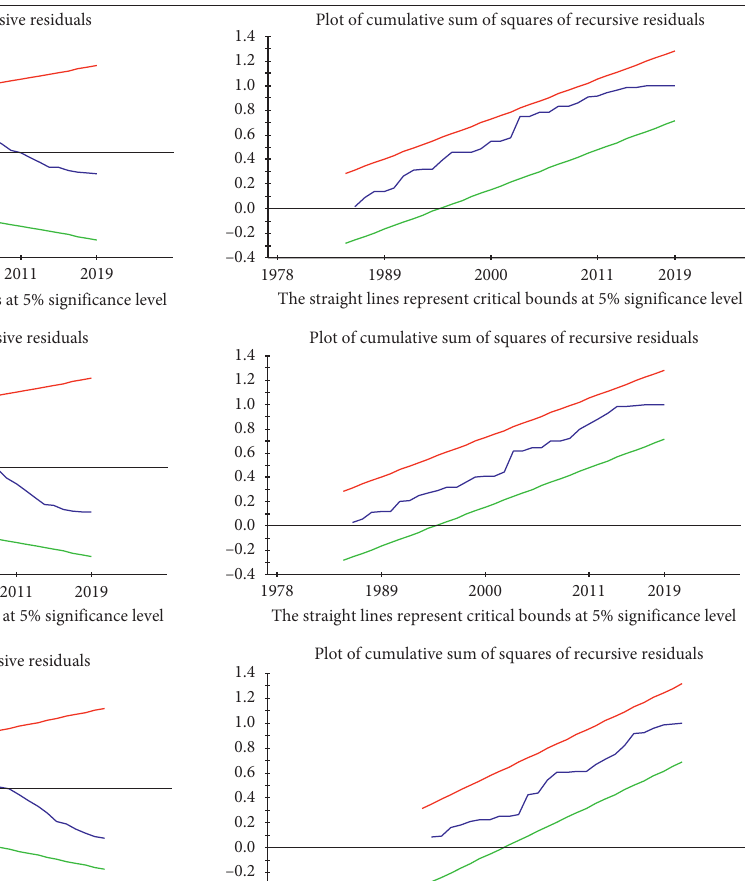
of cumulative sum of squares of recursive residuals